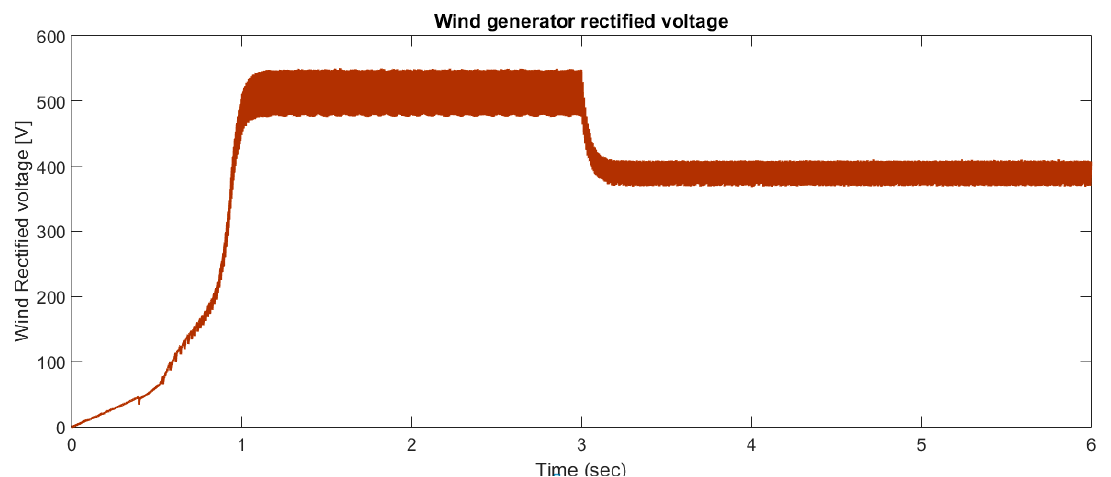
Figure 18. Wind generator output voltage and current.